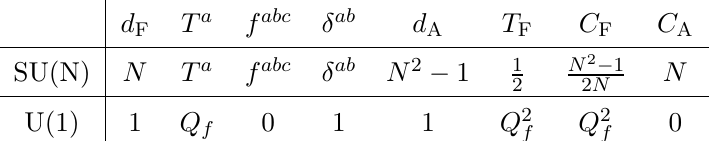
Q 4 and f F ! ! P P Q 4 f 0 f 0 !